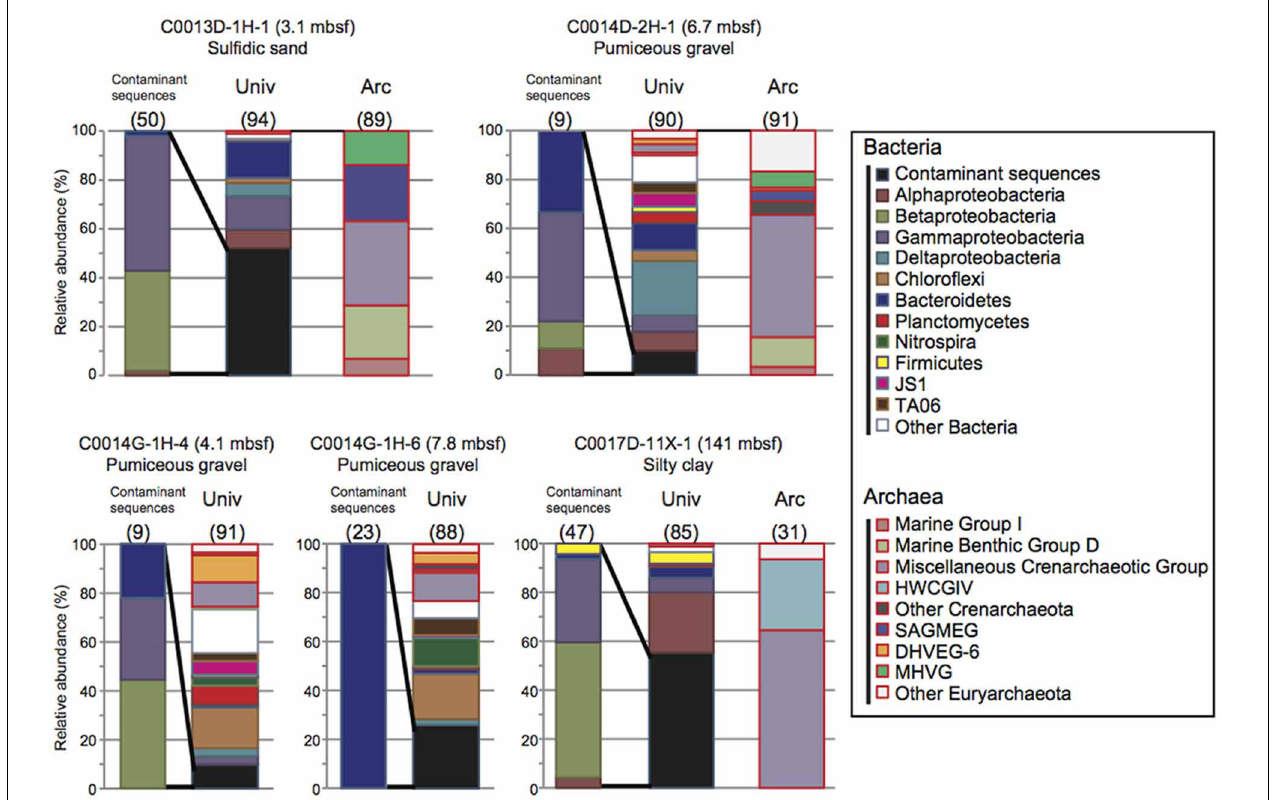
FIGURE 3 | Microbial community structures based on 16S rRNA gene clone libraries in the core samples obtained during IODP Expedition 331. The phylotypes that exhibited greater than 97% similarity to the drilling mud fluid sequences were defined as possible contaminants. Univ;